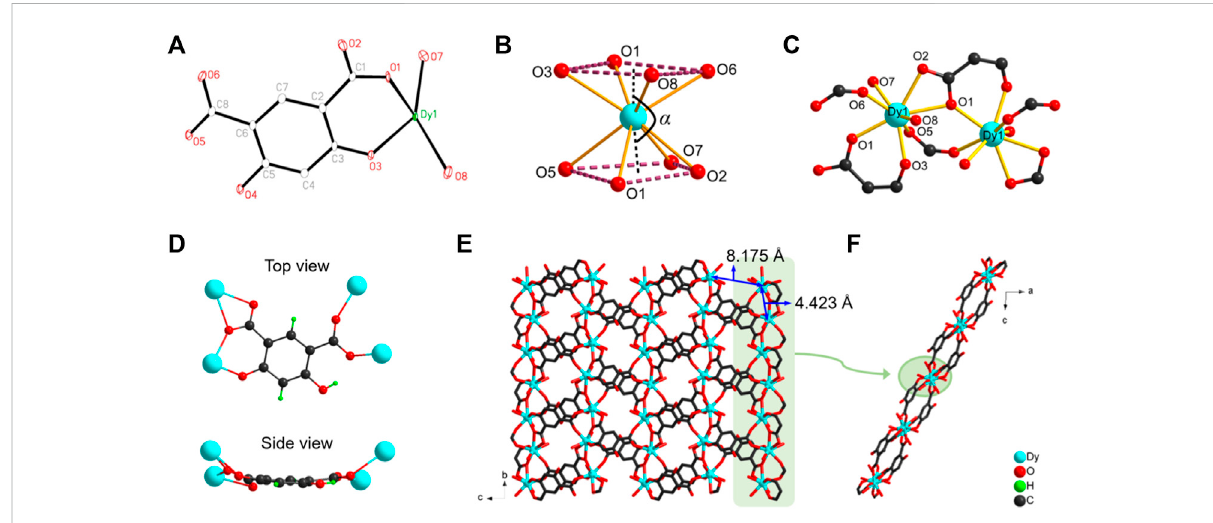
FIGURE 1 (A) The labeled asymmetric unit of Dy-CP (B) coordination sphere of Dy1 center (C) connection between adjacent metal centers (D) top view andsideviewofcoordinationmodeofHm-dobdc 3 − linker (E) 2Dstructureof Dy-CP inthe bc plane (F) sideviewofthe2Dlayer.UncoordinatedH 2 O molecules are removed for clarity.